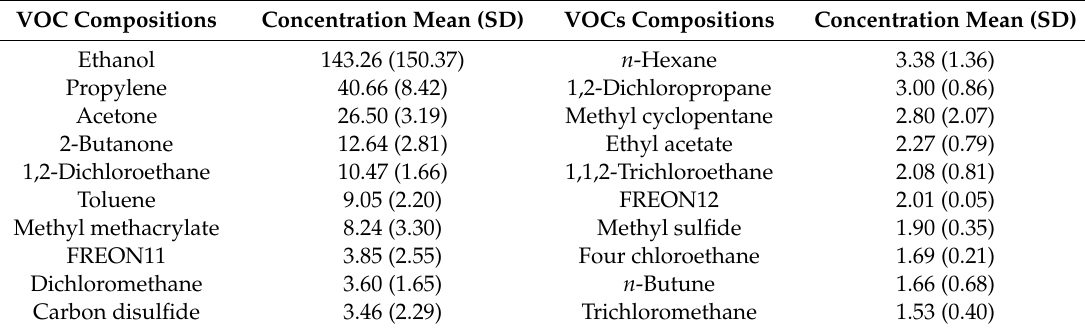
Table 4. Top 20 most abundant VOC species ( µ g m − 3 ) measured in this